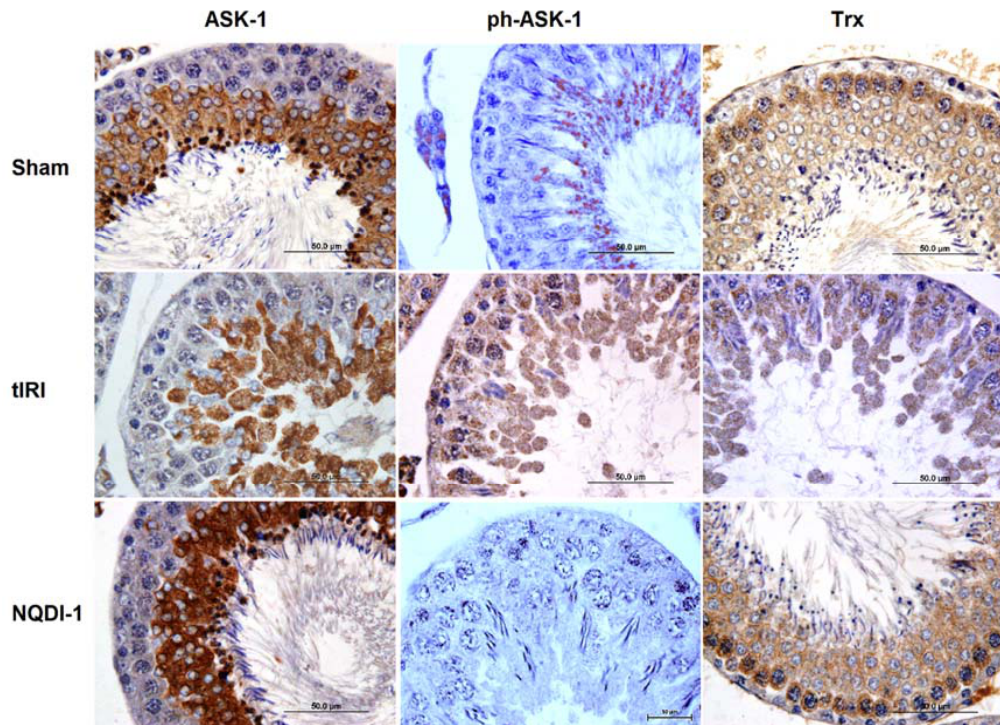
Figure 7. NQDI ‐ 1 modulates the expression of the ASK ‐ 1/Trx axis. The immunoexpression of the ASK ‐ 1, ph ‐ ASK ‐ 1, and Trx were evaluated by IHC staining under light microscopy. Both Trx and ASK ‐ 1 showed reduced immunoreactivity in the tIRI ‐ subjected testes in comparison with sham NQDI ‐ 1 treated groups. As for ph ‐ ASK ‐ 1, it showed strong immunoreactivity in the tIRI ‐ subjected testes in comparison with sham NQDI ‐ 1 treated groups. Contralateral testes showed no significant difference between the three animal groups. NQDI ‐ 1 (10 mg/kg) was injected i.p. 30 min post ischemia. Images were taken at 10× and 40× magnification with a scale bar of 50 μ